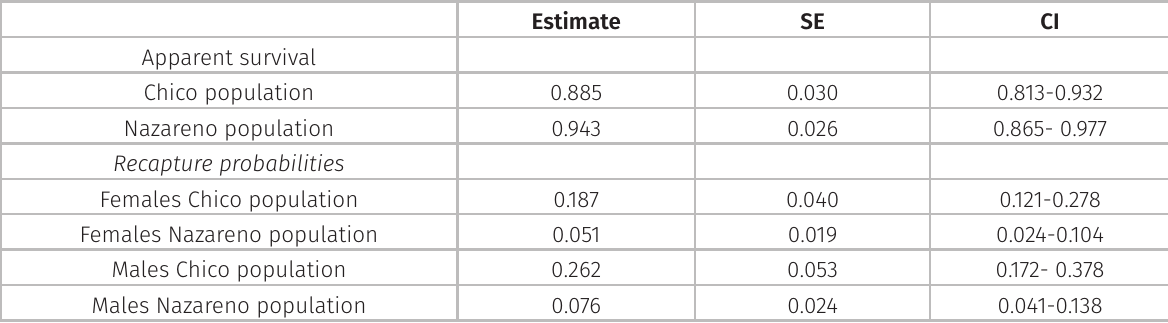
Table III. Real estimates of apparent survival and recaptures probabilities of Homonota taragui corresponding to the most parsimonious model (Φ p ). SE, standard error; CI, confidence intervals a2+p s+p